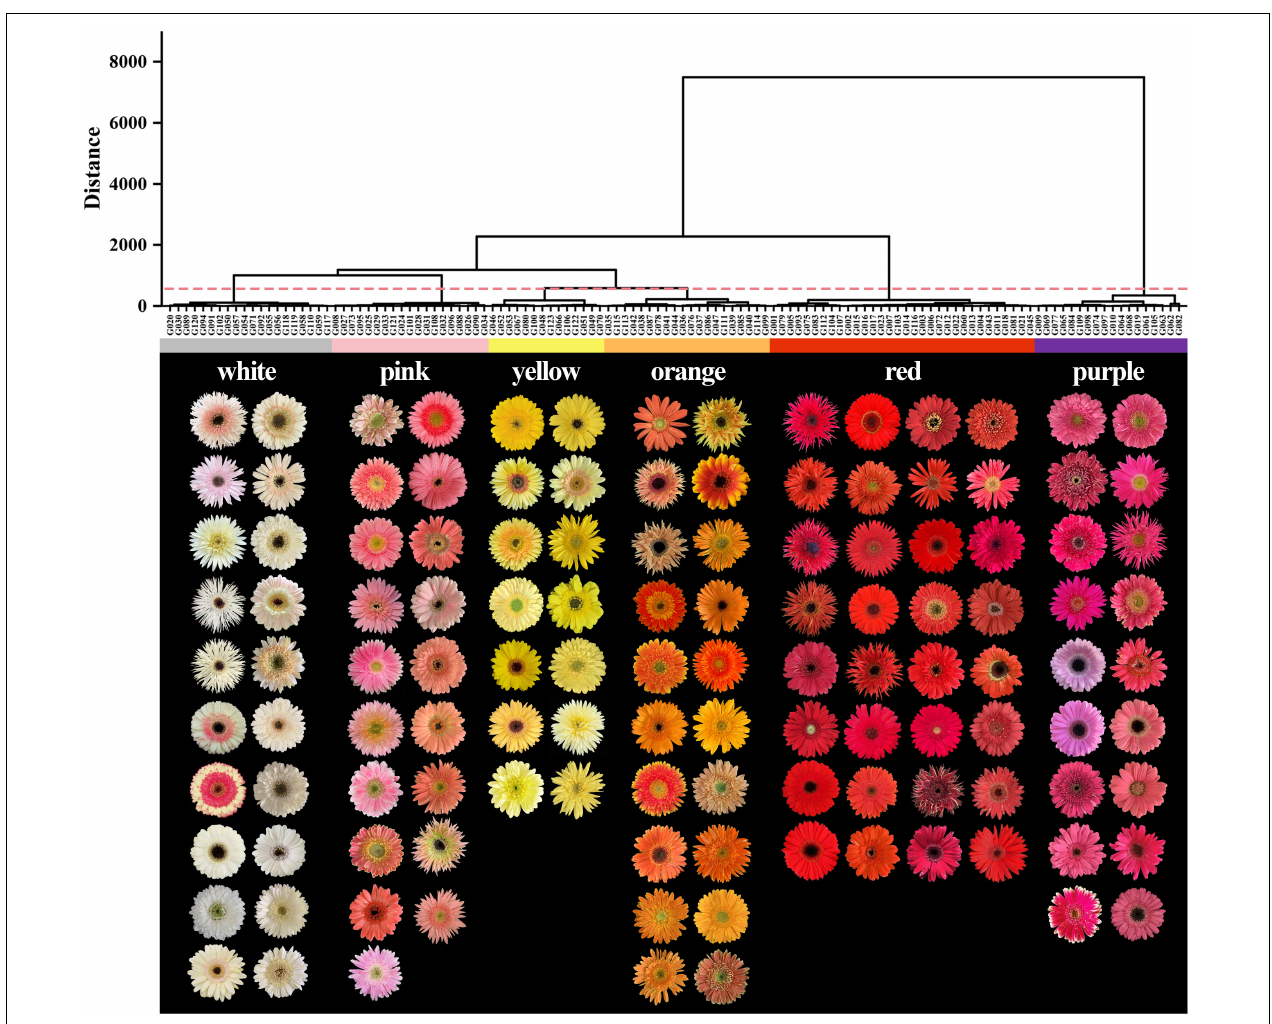
FIGURE 1 | Classification for 123 gerbera accessions based on L* , a* , b* , C , and h of flower